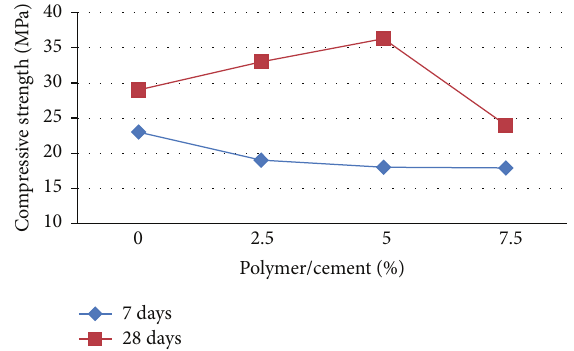
Figure 4: The setting time of polymer modified cement paste with 15% MK.